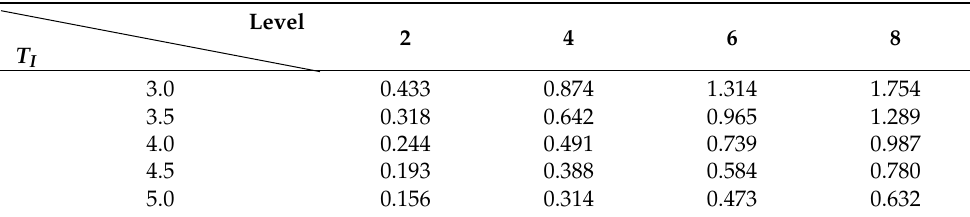
Table 2. Initial pressures inside the pneumatic piston (MPa) according to the rack levels and T I . Level T I